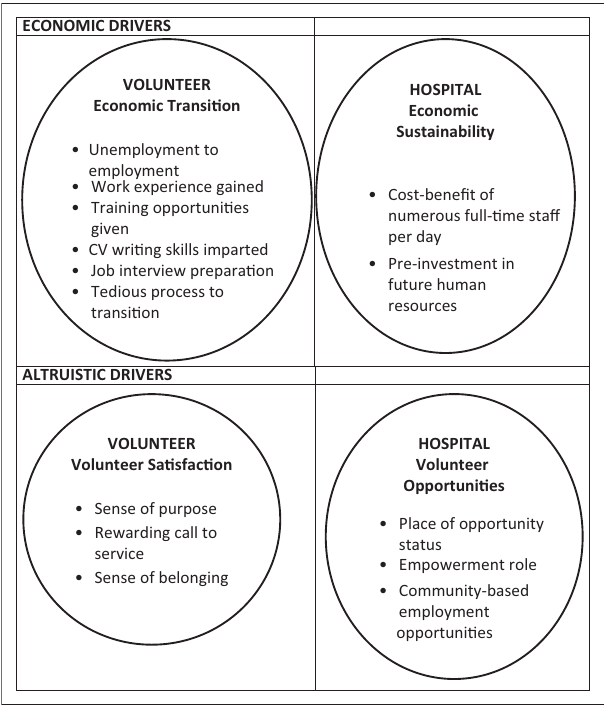
FIGURE 1: Economic and altruistic drivers in volunteer